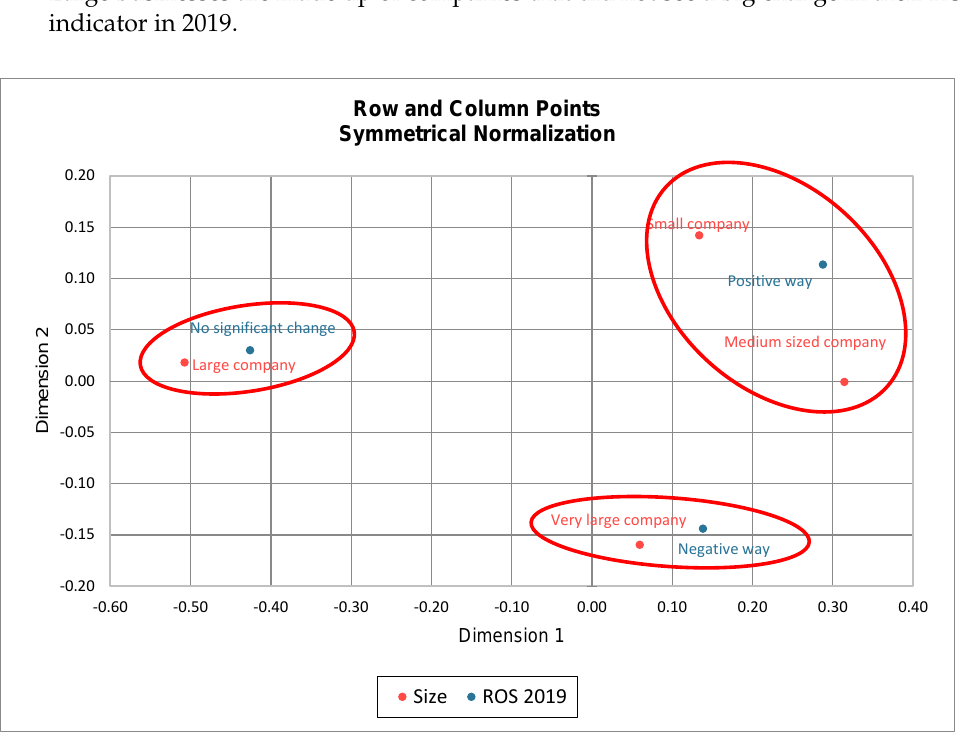
Figure 12. Correspondence map for ROS indicators in 2019 and enterprise size categories. Source: own research .